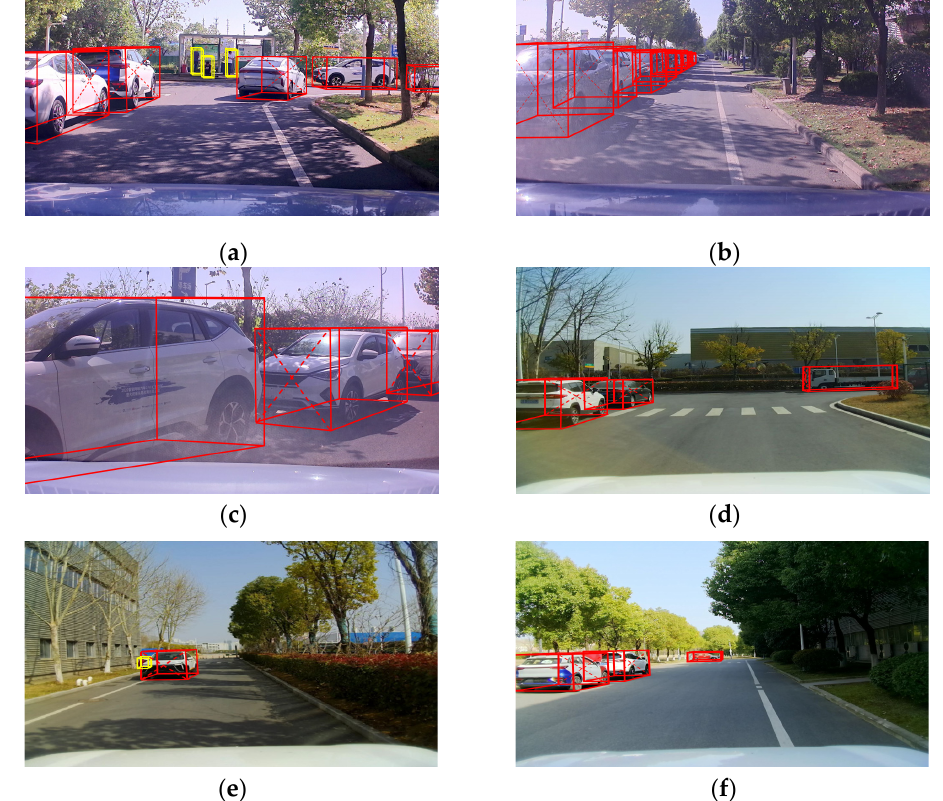
Figure 16. Detection results in different scenarios. ( a – f ) are the results of the improved algorithm for different occlusion situations and different lighting conditions